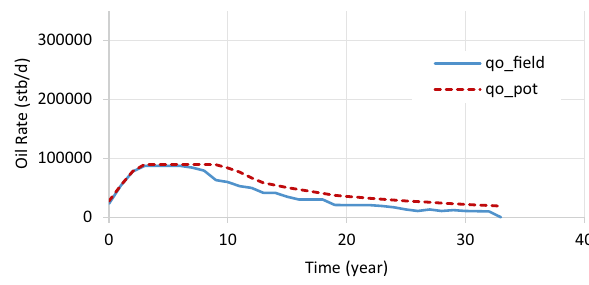
Fig. 21 Optimum oil production profile and oil production potential for strategy FPSO with GL +